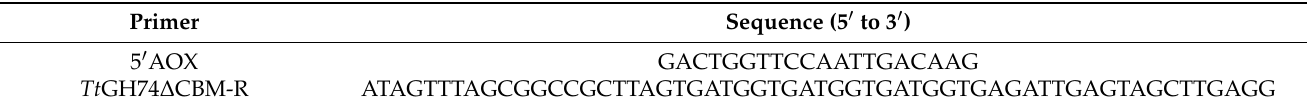
Table 4. Primers used in this